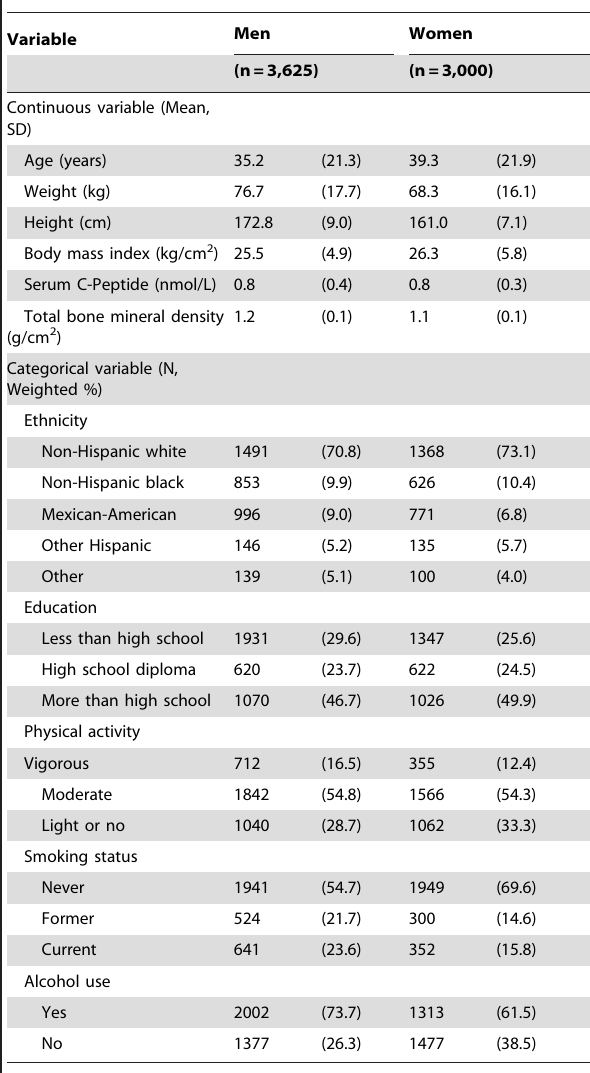
Table 1. Characteristics of study participants by sex from National Health and Nutrition Examination Survey (1999–